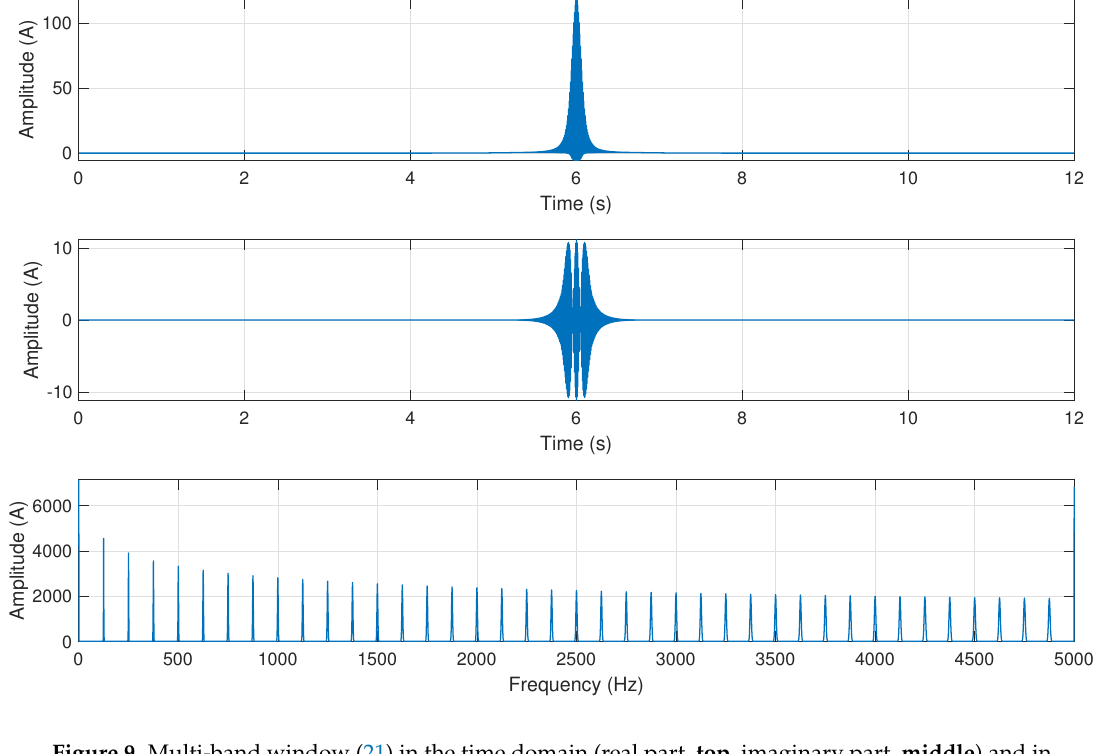
Figure 9. Multi-band window (21) in the time domain (real part, top , imaginary part, middle ) and in the frequency domain ( bottom ). This window contains 40 Gaussian windows, located in 40 adjacent frequency bands of 125 Hz, with values of α ranging from α min = 1 to α max =